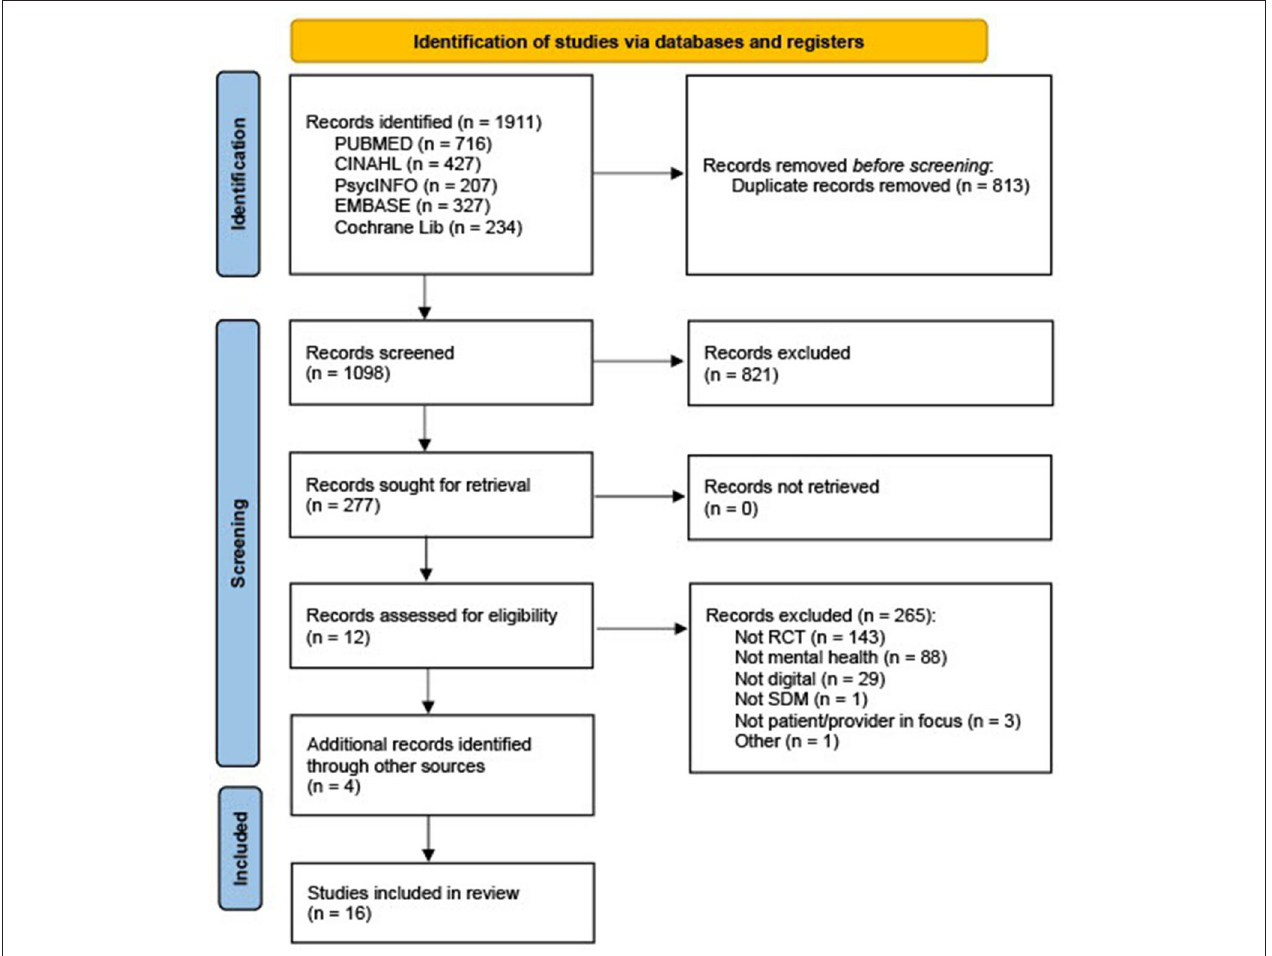
FIGURE 1 | PRISMA flow diagram